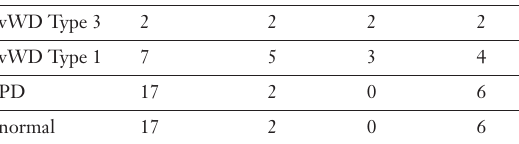
Number of individuals with prolonged EPI-CT, ADP-CT and bleeding time (BT) among patients with von Willebrand disease (vWD), with a mild platelet function disorder (PD) or among patients with no abnormal laboratory findings (normal).